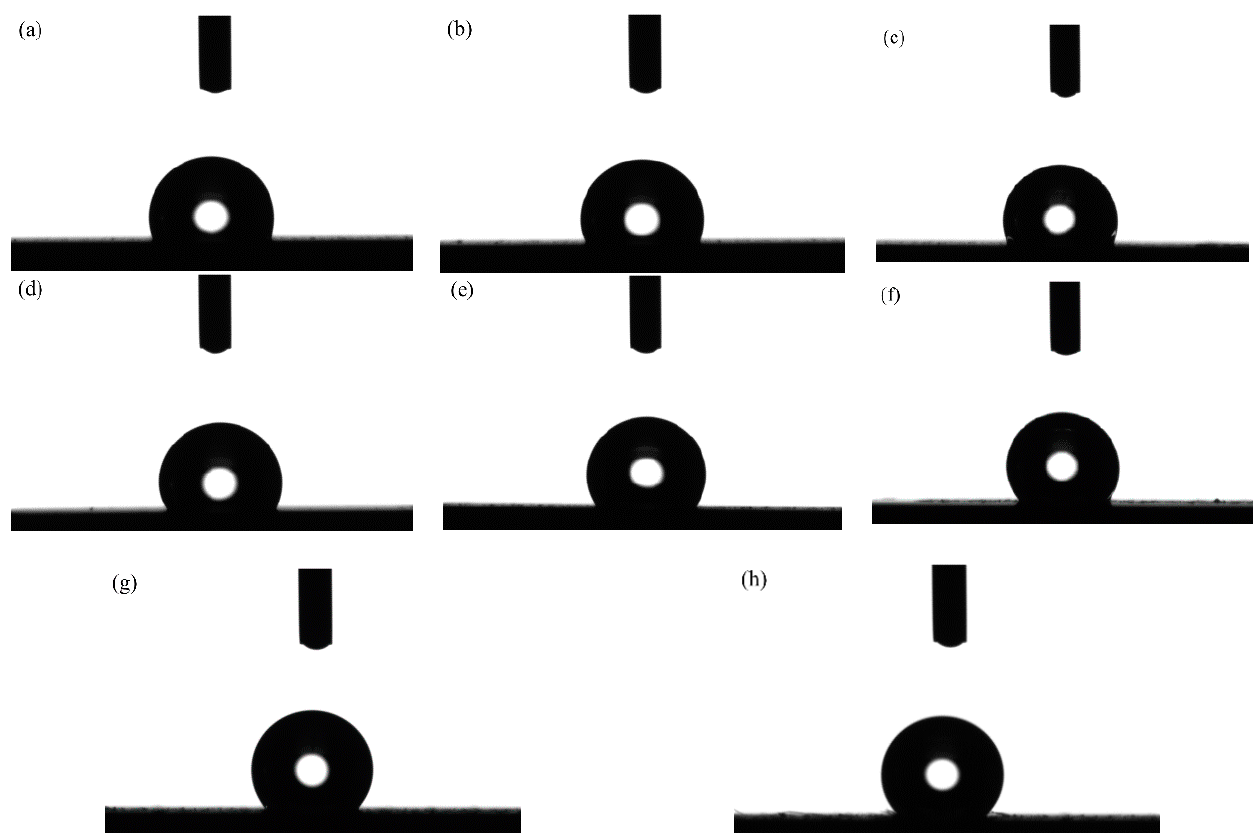
Figure 7. Optical profile of water drops of textured surface with varying laser output power: ( a ) 50 W; ( b ) 60 W; ( c ) 70 W; ( d ) 80 W; ( e ) 90 W; ( f ) 100 W; ( g ) 110 W; ( h ) 120 W.